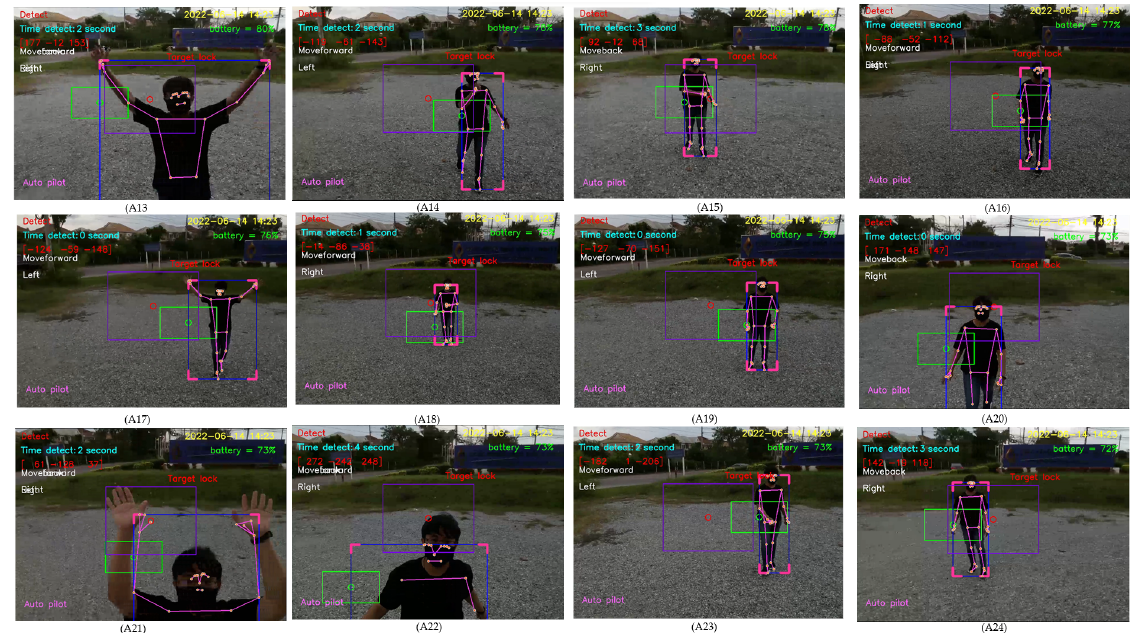
Figure 35. Sampling frames 31–60 of automatic tracking human motion.